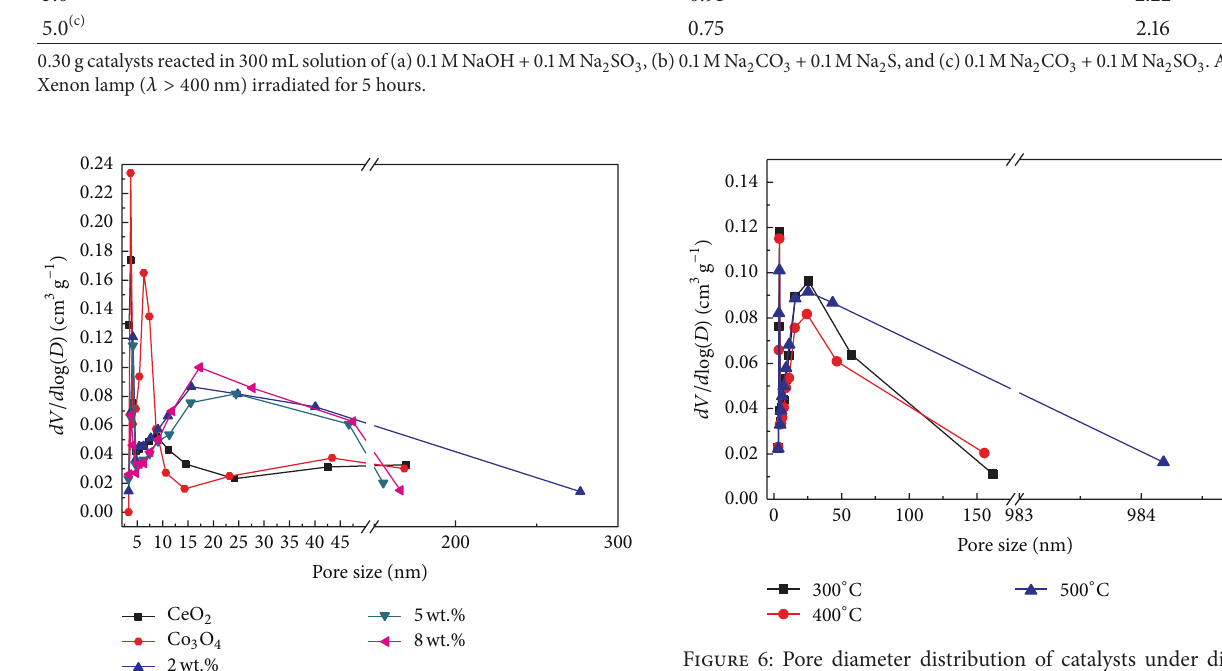
Table 2: Mean methanol and ethanol yield on Co Catalyst mass fraction of Co doping (%)